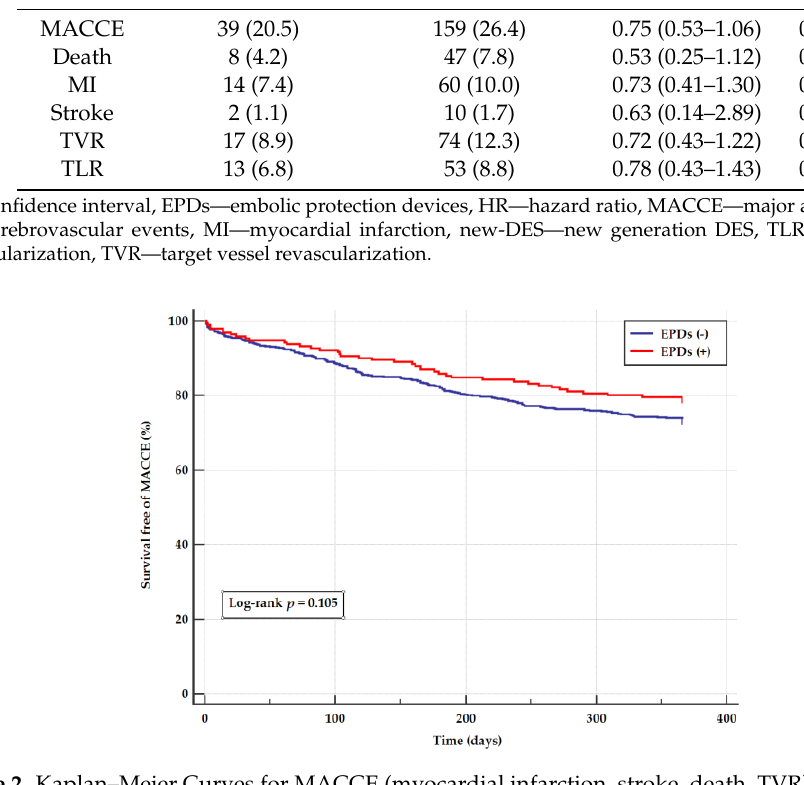
Figure 2. Kaplan–Meier Curves for MACCE (myocardial infarction, stroke, death, TVR) according to the use of embolic protection devices. MACCE—major adverse cardiac and cerebrovascular events.